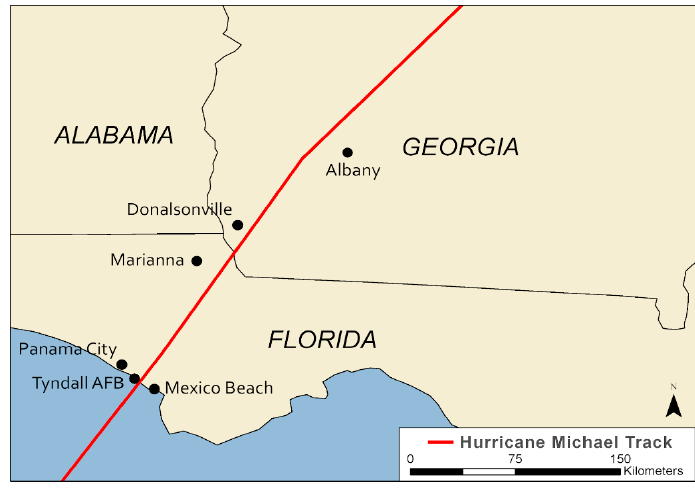
Figure 1. Hurricane Michael track with city names mentioned.